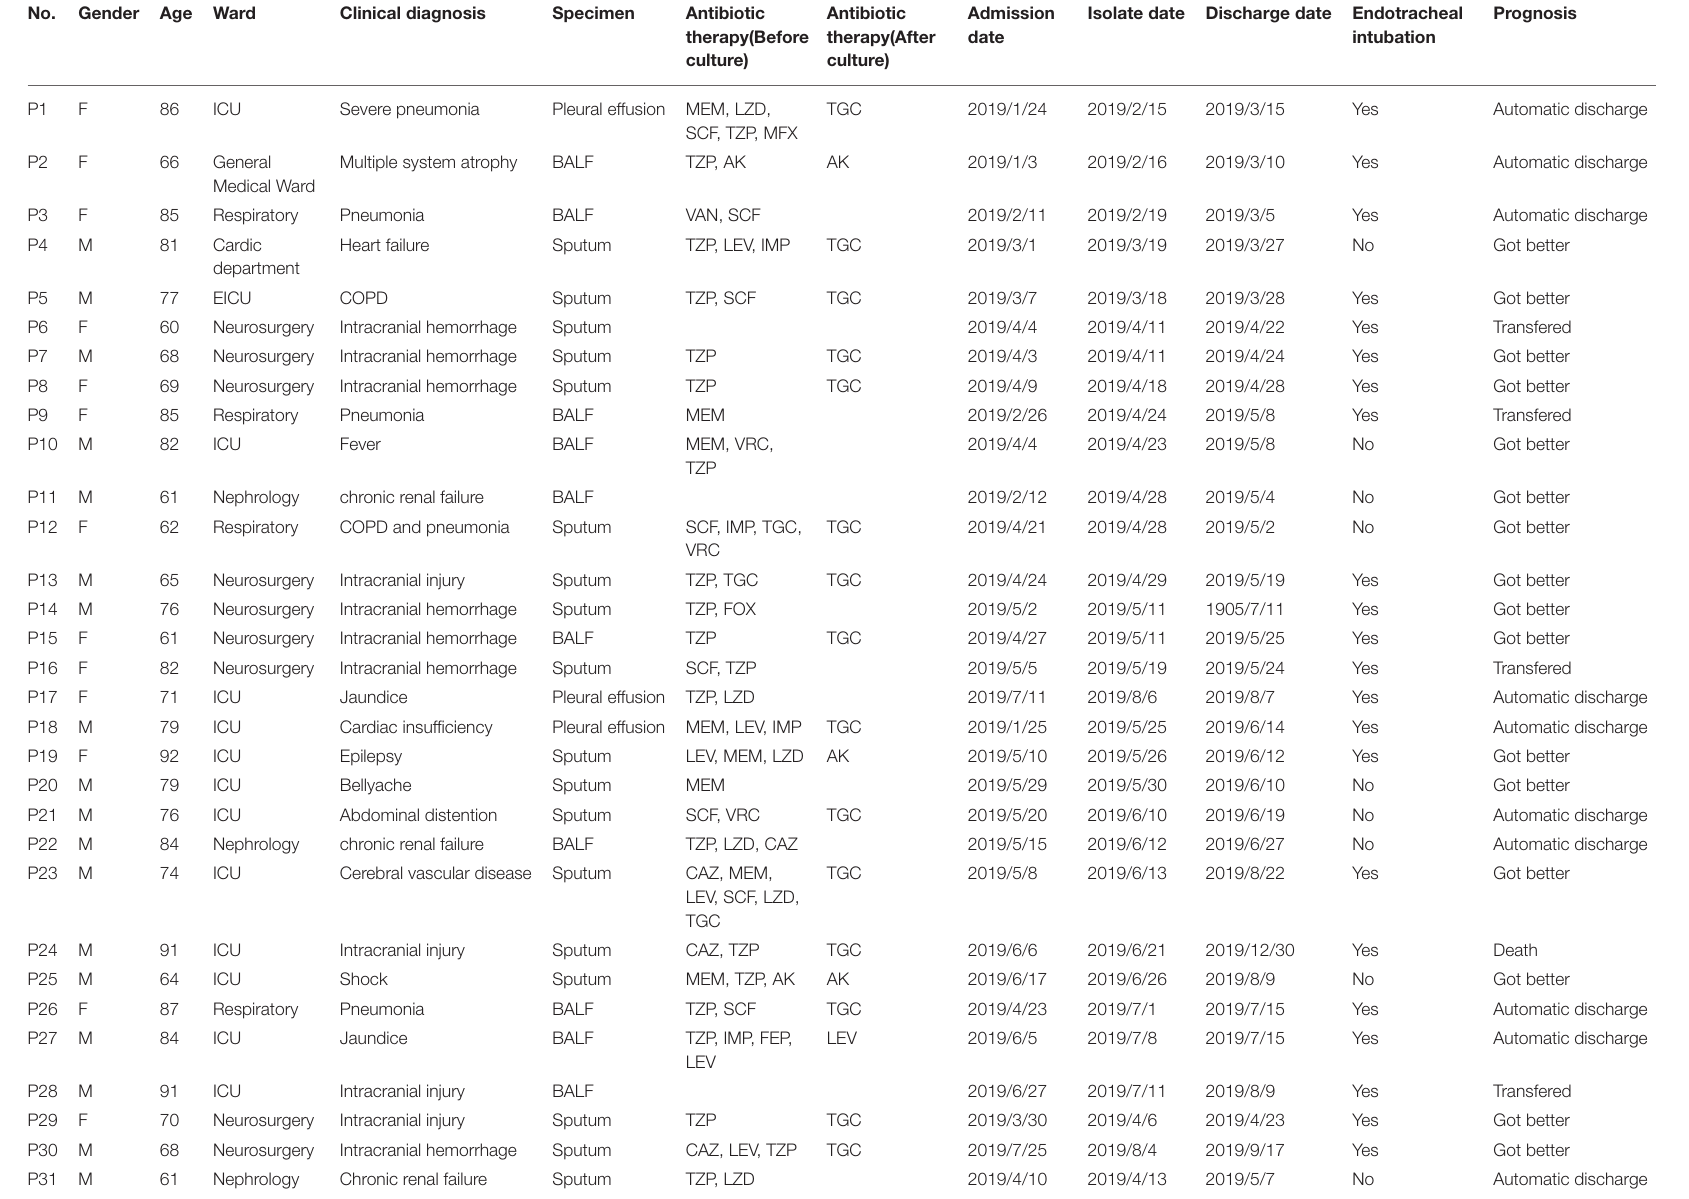
TABLE 1 | Clinical characteristics of 31 elderly patients with LRTIs by